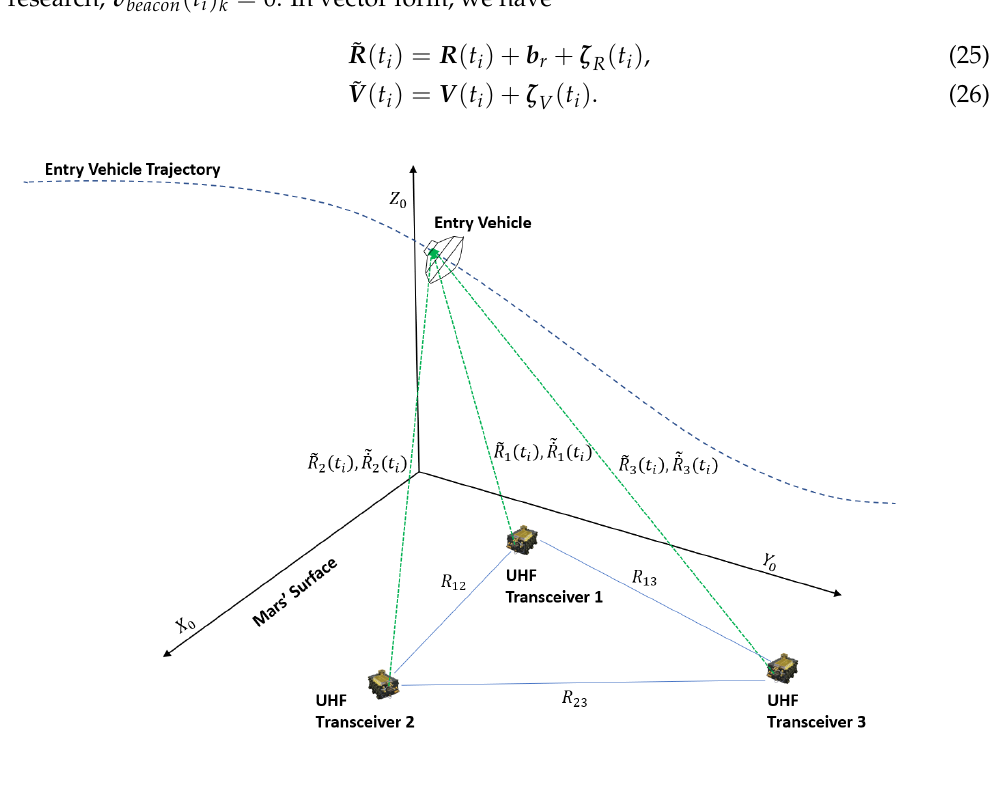
Figure 3. UHF transceiver-based measurement